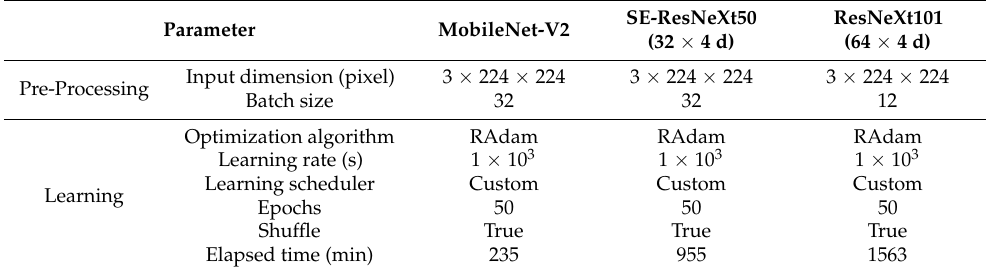
Table 2. Experimental parameters of the